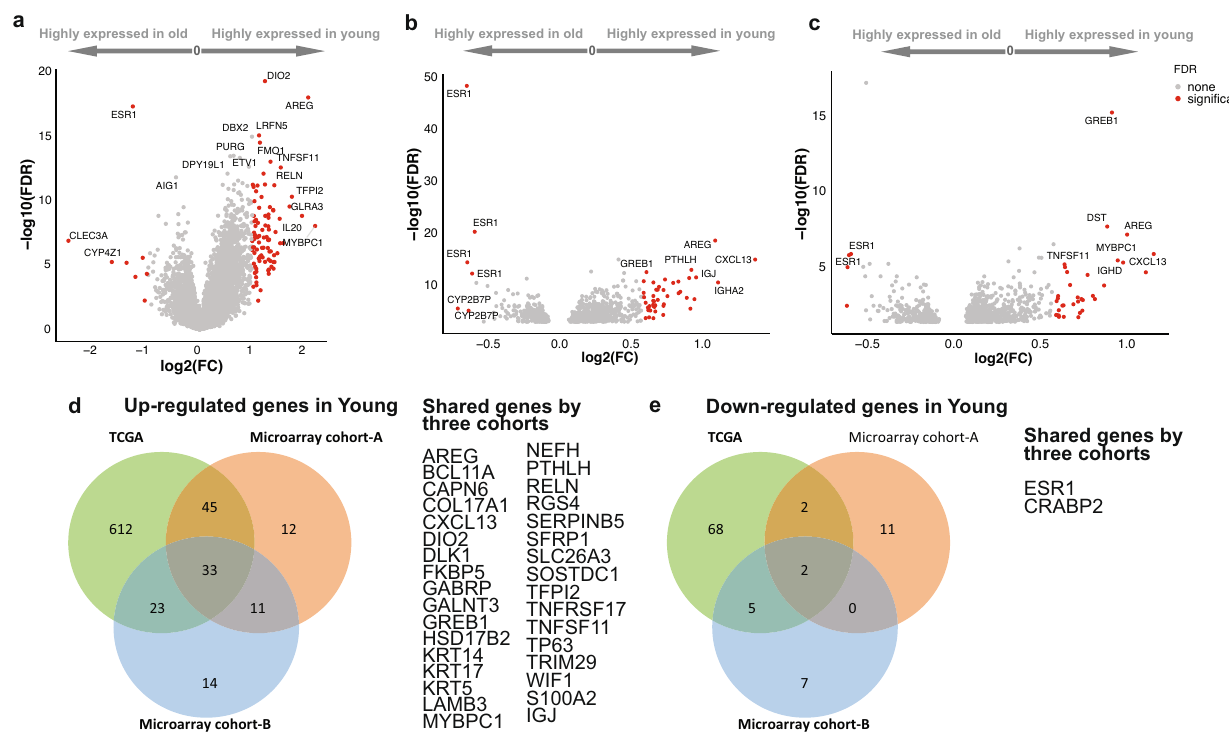
Fig. 2 Differentially expressed genes between younger versus older patients. Volcano plots indicate the log2 fold change (FC) and FDR of differentially expression analysis in three cohorts, including a TCGA cohort; b microarray cohort-A; c microarray cohort-B. P -values were generated by Student ’ s t-test and corrected by Benjamini – Hochberg FDR. Red dots indicated genes meet criteria of fold change ≥ 1.50 or ≤ 0.67 and FDR < 0.05 (signi fi cant), and other genes were marked as gray (none, not signi fi cant). Top enriched genes with fold change ≥ 1.50 or ≤ 0.67 and FDR < 1e − 05 were labeled with of fi cial gene symbols. d , e Venn diagram shows the number of upregulated ( d ) and downregulated ( e ) genes identi fi ed in the TCGA that also showed up- or downregulation in the other two data sets.